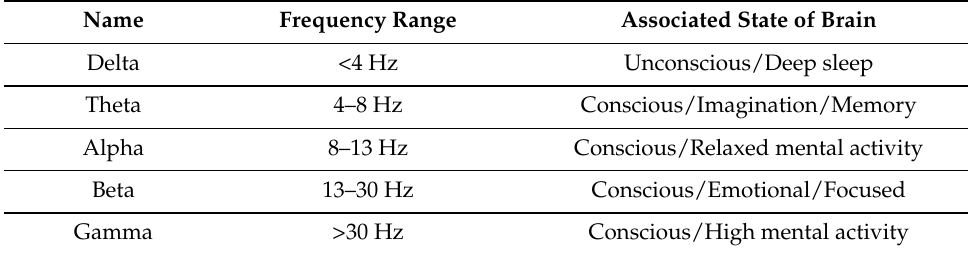
Table 2. Electroencephalography (EEG) frequency brain bands and associated brain